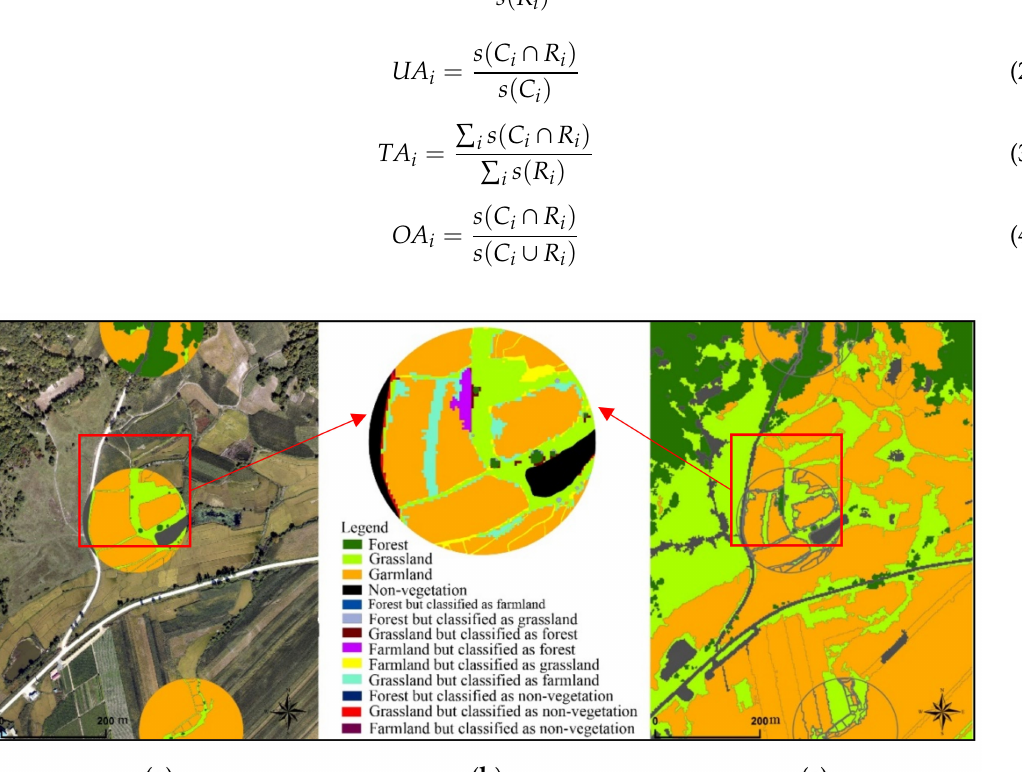
Figure 3. An example of accuracy evaluation of L2 layer according to the area-based method. ( a ) Reference vector polygon; ( b ) a validating multi-category graph generated by intersection operation and ( c ) final classification result of the vegetation